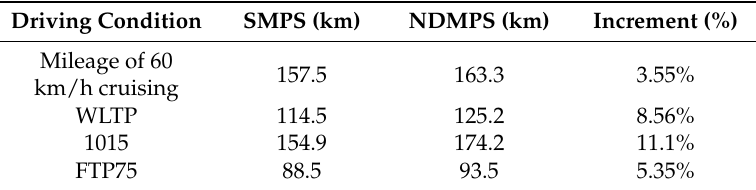
Figure 10. Simulation results of state of charge ( SOC ) under different driving cycles. Table 7. Comparison of vehicle economic